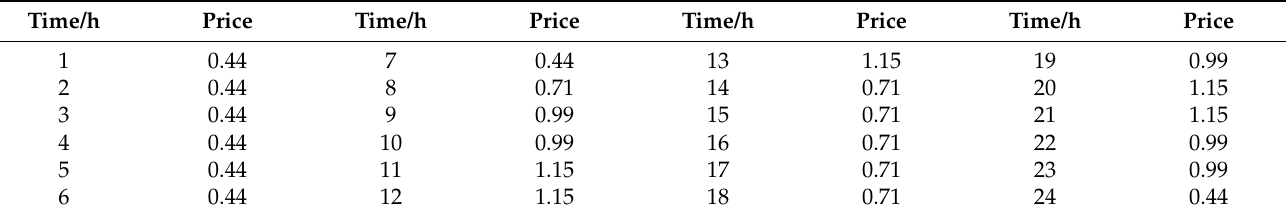
Table 5. Twenty-four-hour electricity price